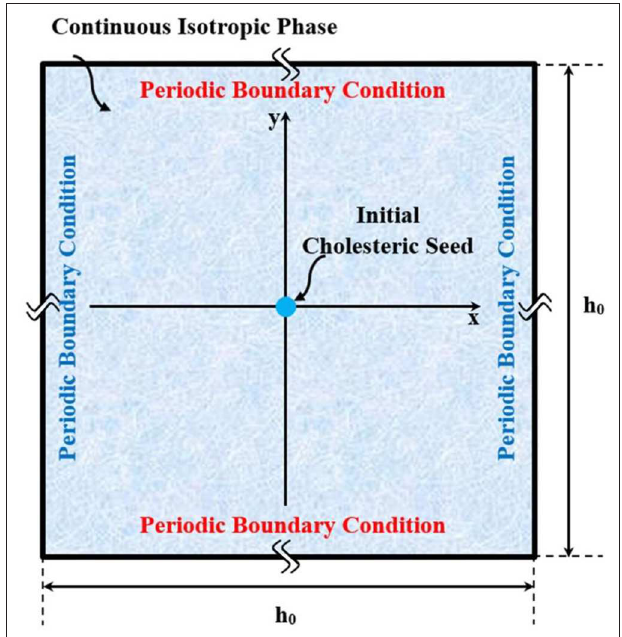
FIGURE 2 | Schematic of the computational domain, in which a small chiral nematic drop is initially seeded, and allowed to naturally grow in coexistence with an isotropic